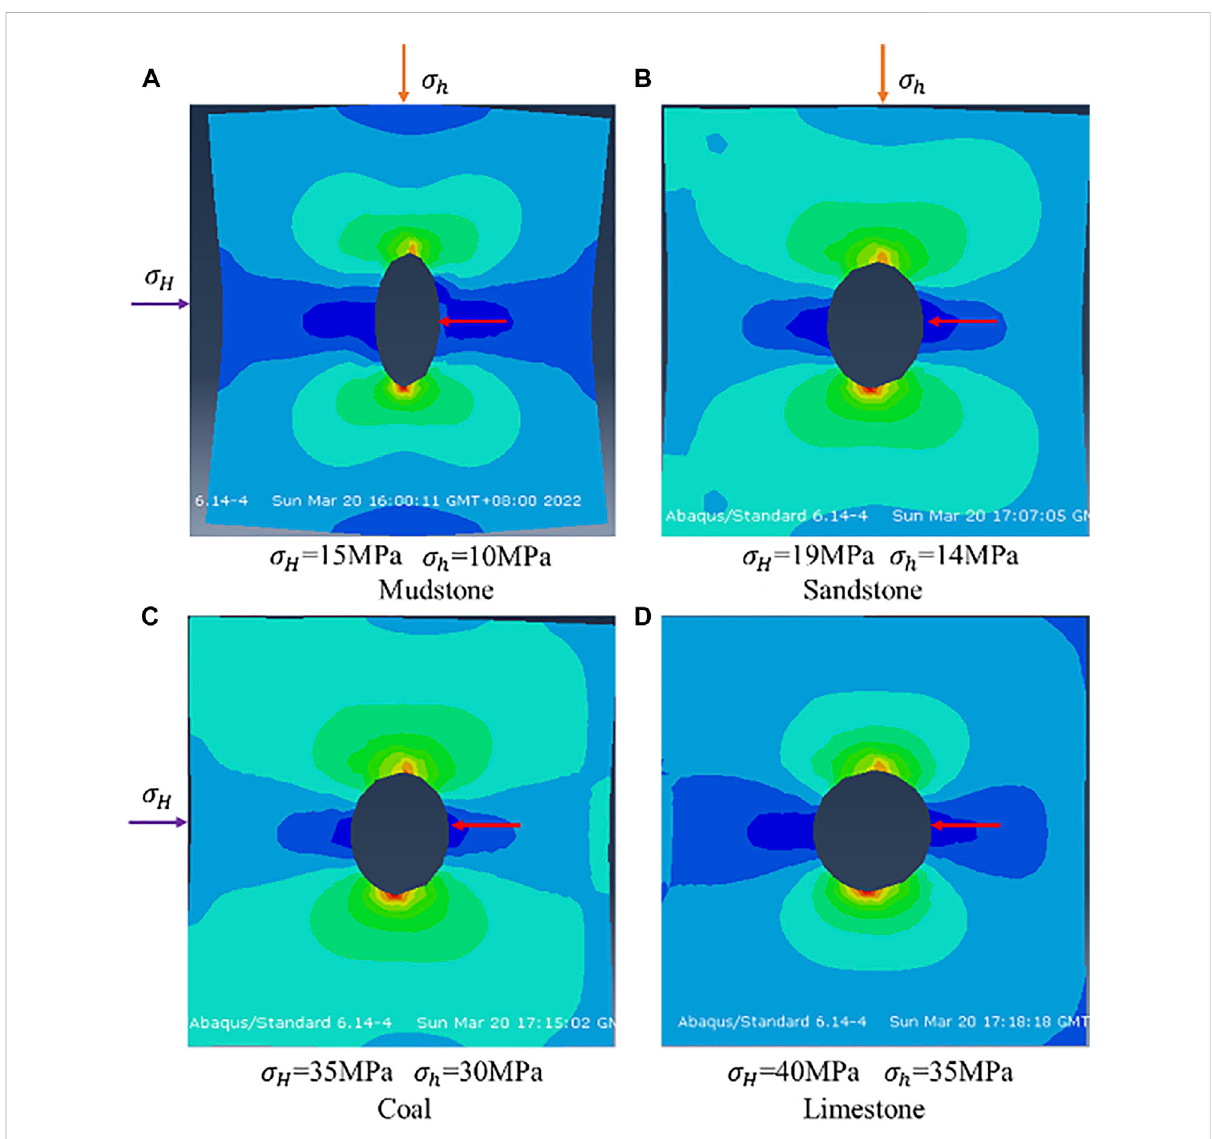
FIGURE 11 Numerical simulation of the borehole morphology of different lithologies under in situ